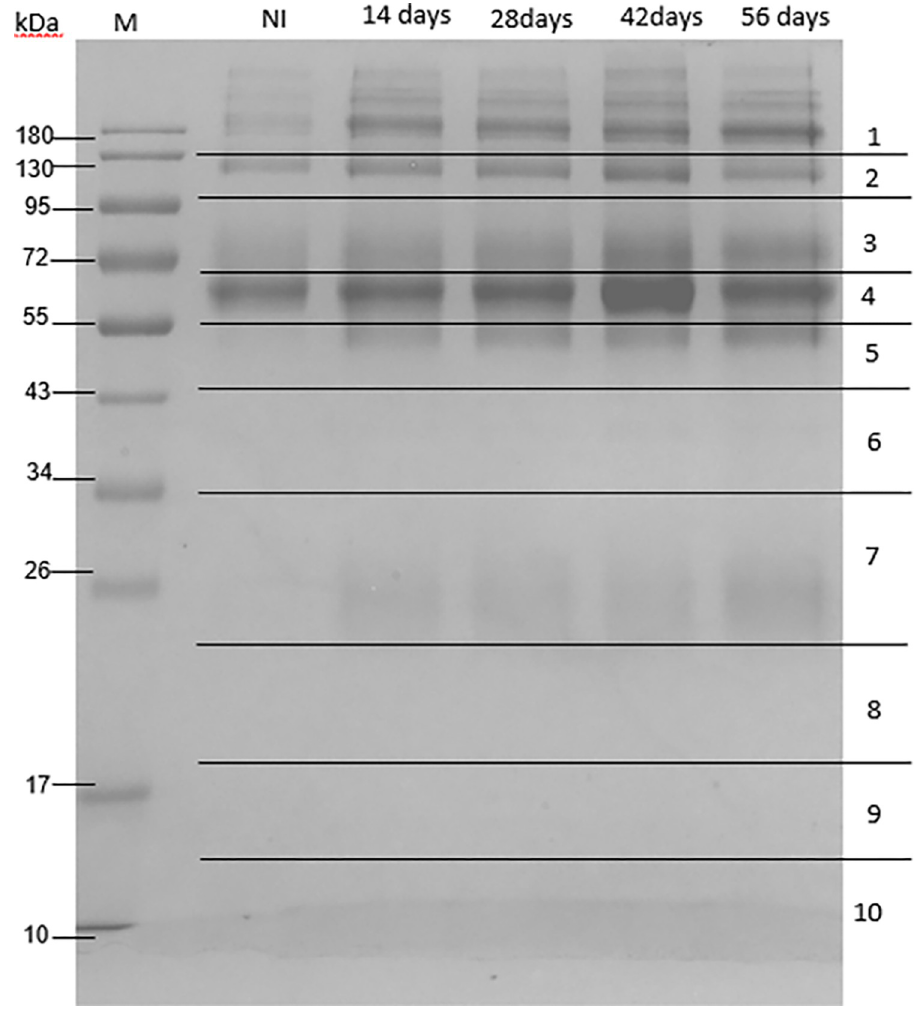
Fig 6. SDS-PAGE analysis of circulating antigens from immune complexes in sera from mice with and without S . mekongi infection. Immune complexes were enriched using protein A/G magnetic beads and separated with 12% SDS-PAGE. M: Marker; NI: Uninfected; 14-, 28-, 42-, and 56-days post-infection. The 10 horizontal sections represent regions excised for mass spectrometric